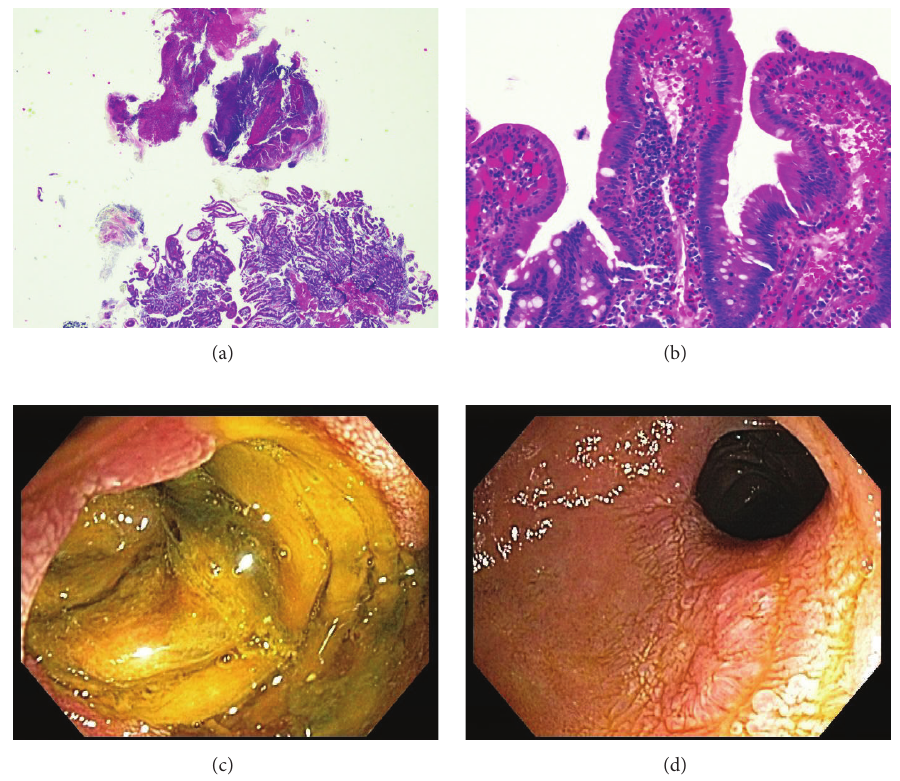
Figure 2: Vasculitis-associated duodenitis. (a) H&E staining from duodenal biopsy (40x) showing fibrinopurulent exudate consistent with ulceration/erosion. (b) H&E staining from duodenal biopsy (200x) showing active duodenitis including neutrophils within the surface epithelium and in the lamina propria surrounding small vessels with capillary ectasia and red blood cell extravasation. (c) EGD image of active duodenitis. (d) EGD image of mild to moderate duodenal